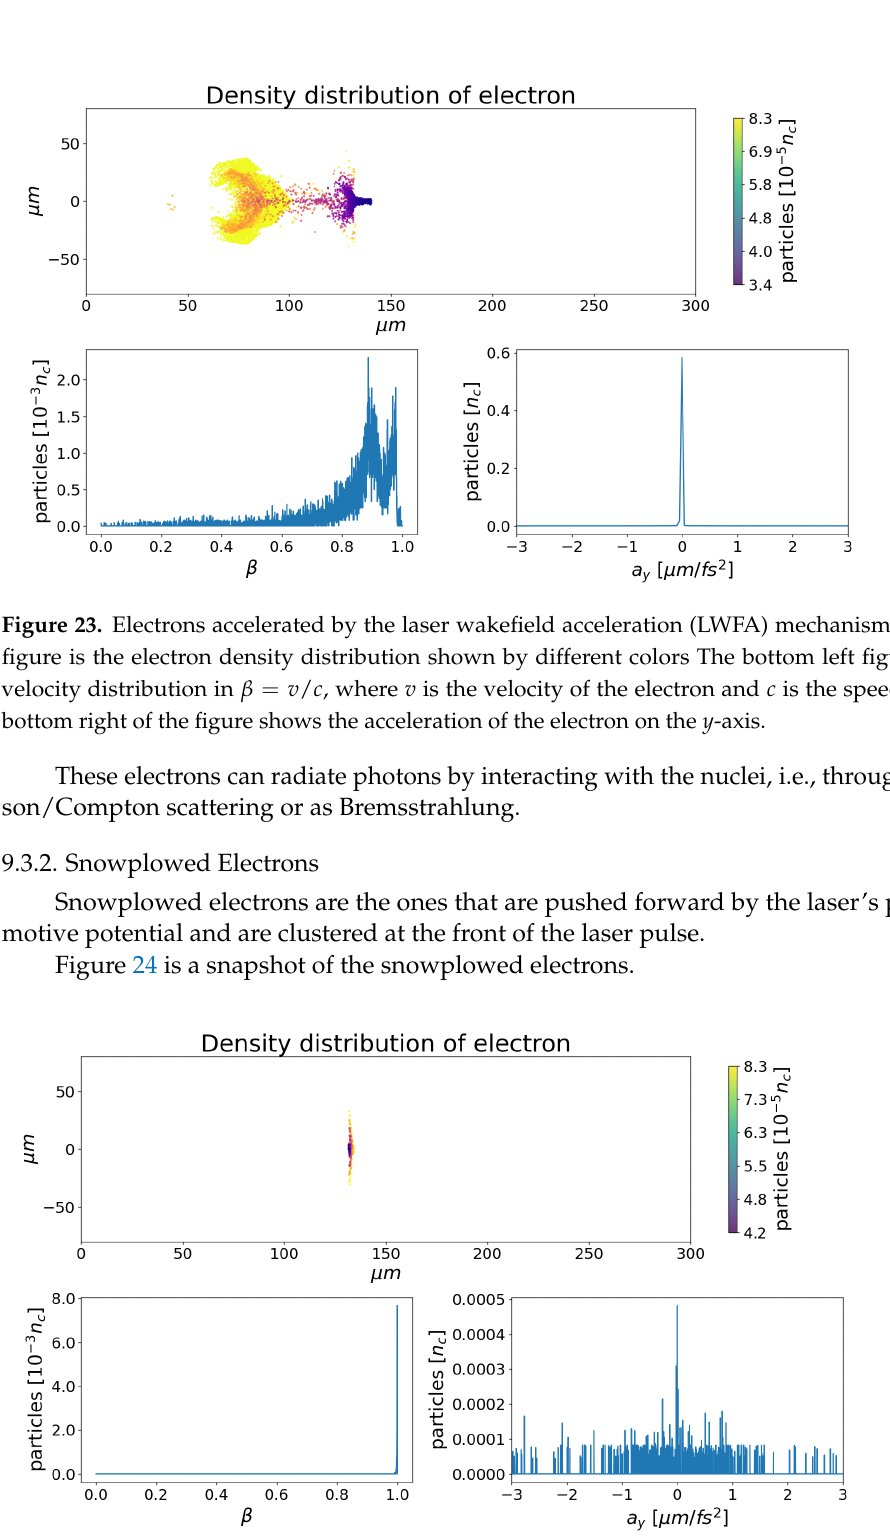
Figure 24. Snowplowed electrons. The top figure is the electron density distribution shown by color. The bottom left figure is the velocity distribution in β = v / c , where v is the velocity of the electron and c is the speed of light. The bottom right of the figure shows the acceleration of the electron on the y